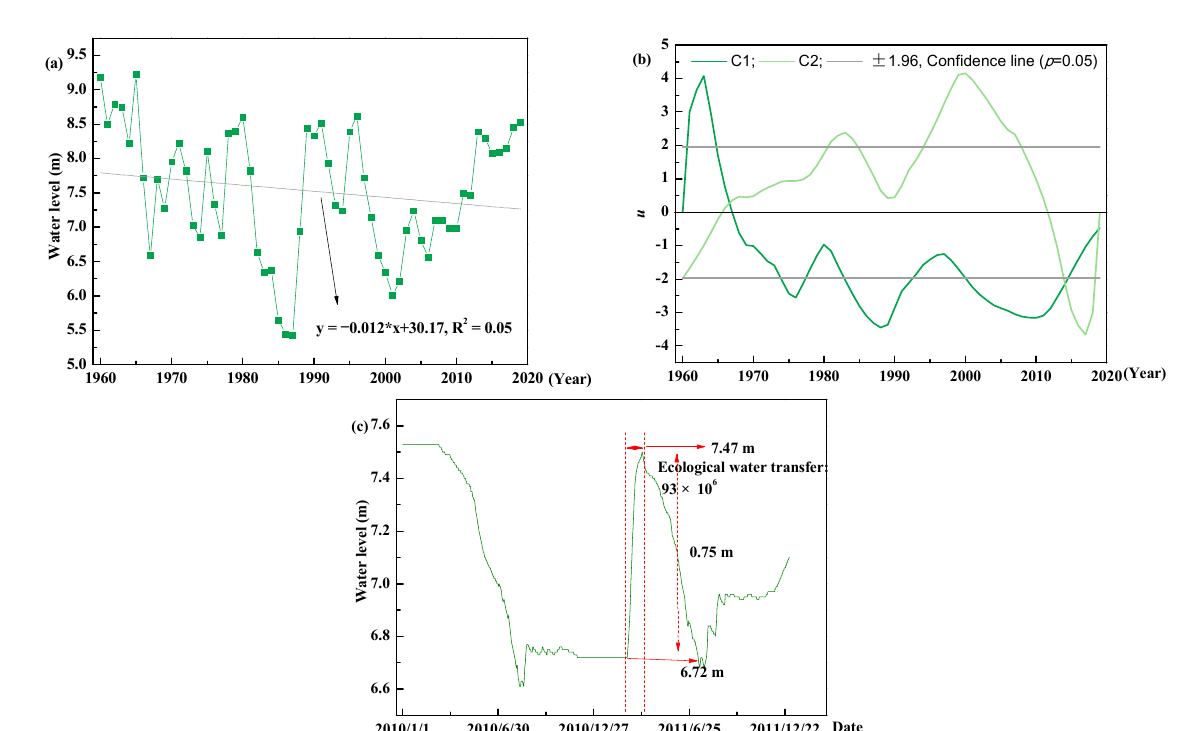
Figure 2. The temporal variation of water level for Baiyangdian wetland. ( a ) temporal trend for water level; ( b ) abrupt changes for water level detected by the Mann-Kendall method; and ( c ) a water level fluctuation example caused by the ecological water transfer from December 2010 to March 2011. The u represents statistics variables in the Mann-Kendall method, C 1 and C 2 is statistical variables calculated from normal and invert series. The intersection point of C 1 and C 2 located between the confidence lines (±1.96 at 95% confidence line) is the time of the abrupt changes [24,25].